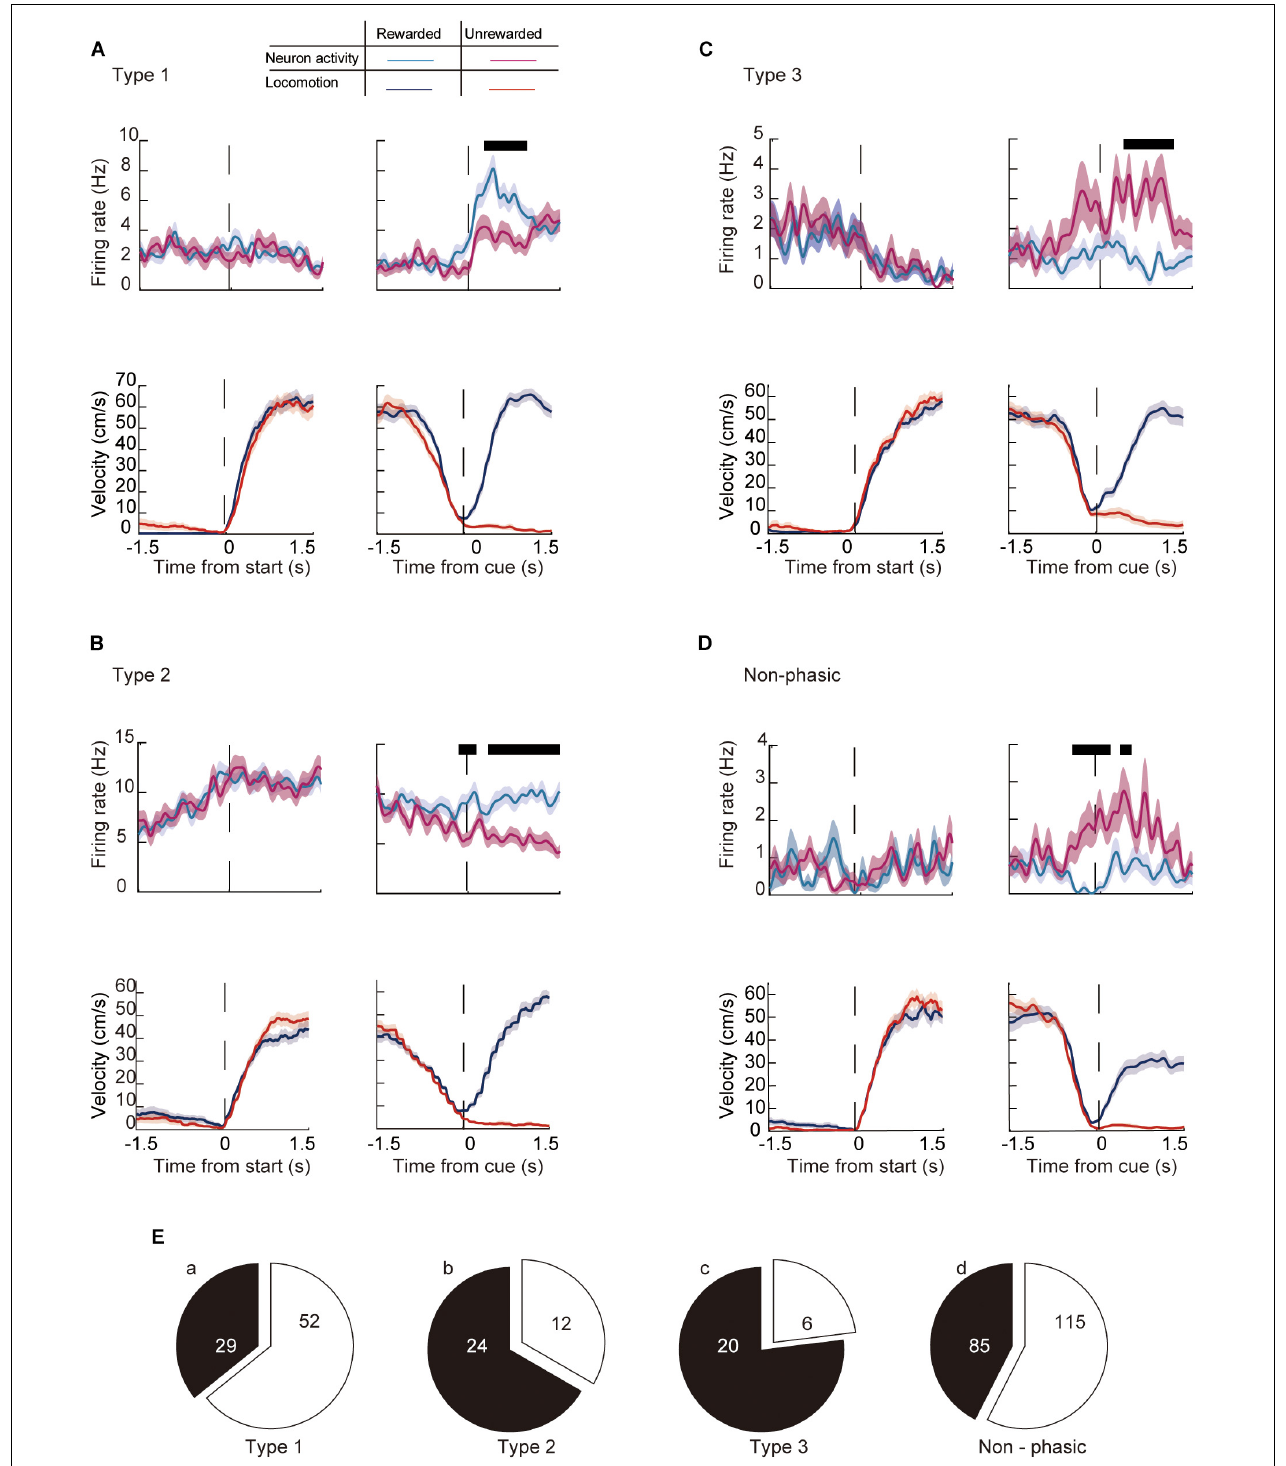
FIGURE 8 | Modulation of the firing activity of ACC neurons around the key task by behavioral outcome in the current trial. Examples of the running velocity (upper panels) and neuronal activity (lower panels) of (A) a Type 1, (B) a Type 2, (C) a Type 3, and (D) a non-phasic neuron around the start and cue presentation, during rewarded (blue lines for the running velocity, cyan for the firing rate) and non-rewarded trials (red lines for the running velocity, magenta for the firing rate). Thick black lines in each panel represent significantly different segments ( P < 0.05; see section “Materials and Methods”). (E) Number of significantly modulated (a) Type 1, (b) Type 2, (c) Type 3, and (d) non-phasic neurons. Shaded areas in each trace indicate the SEM.